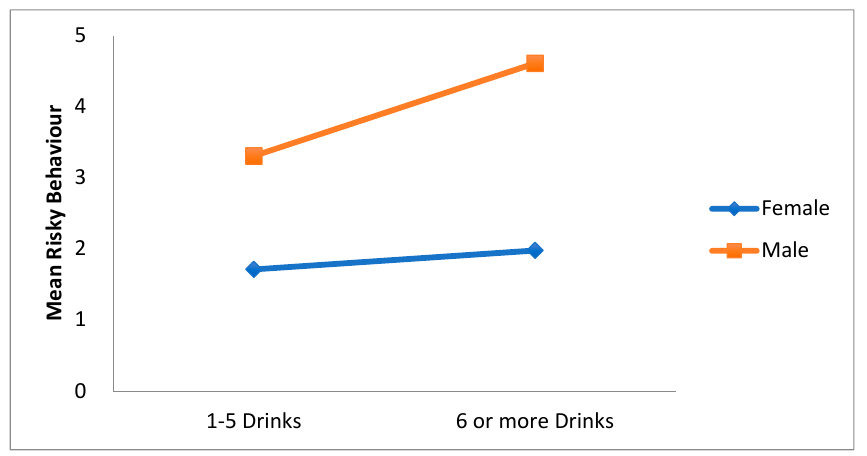
Figure 5. Interaction effect of gender on the relationship between intensity of energy drinks (1–5/6 or more drinks) and overall risky behavior.